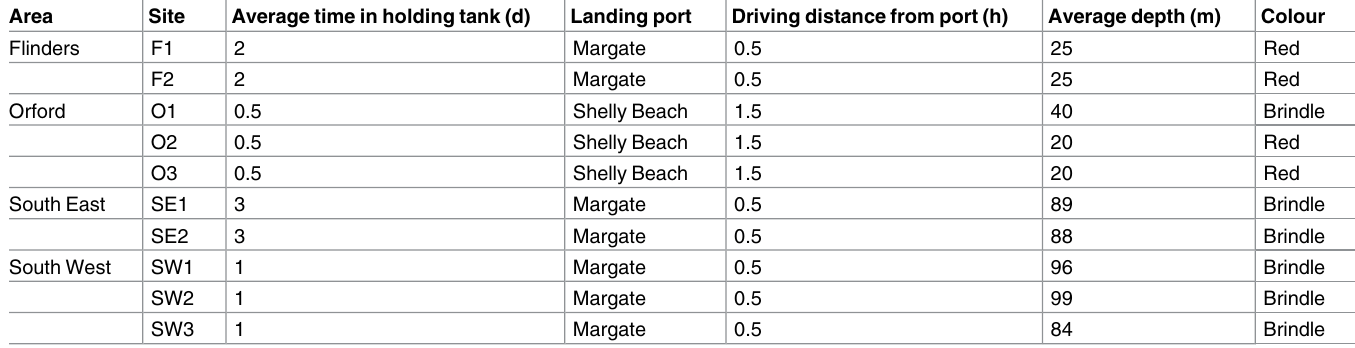
Table 1. Lobster colour and averagedepth of sites located in different areasaround Tasmania. Landingport locationsare shown in Fig 1. Area